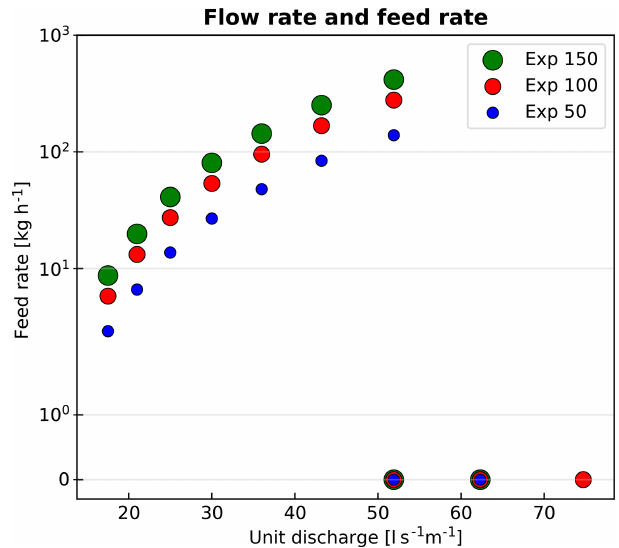
Figure 3. Flow rates and feed rates used in the three experiments. The marker size is proportional to the feed rate. After 7h, in each experiment (see Table 1), we increased the flow rate without feeding sediment.